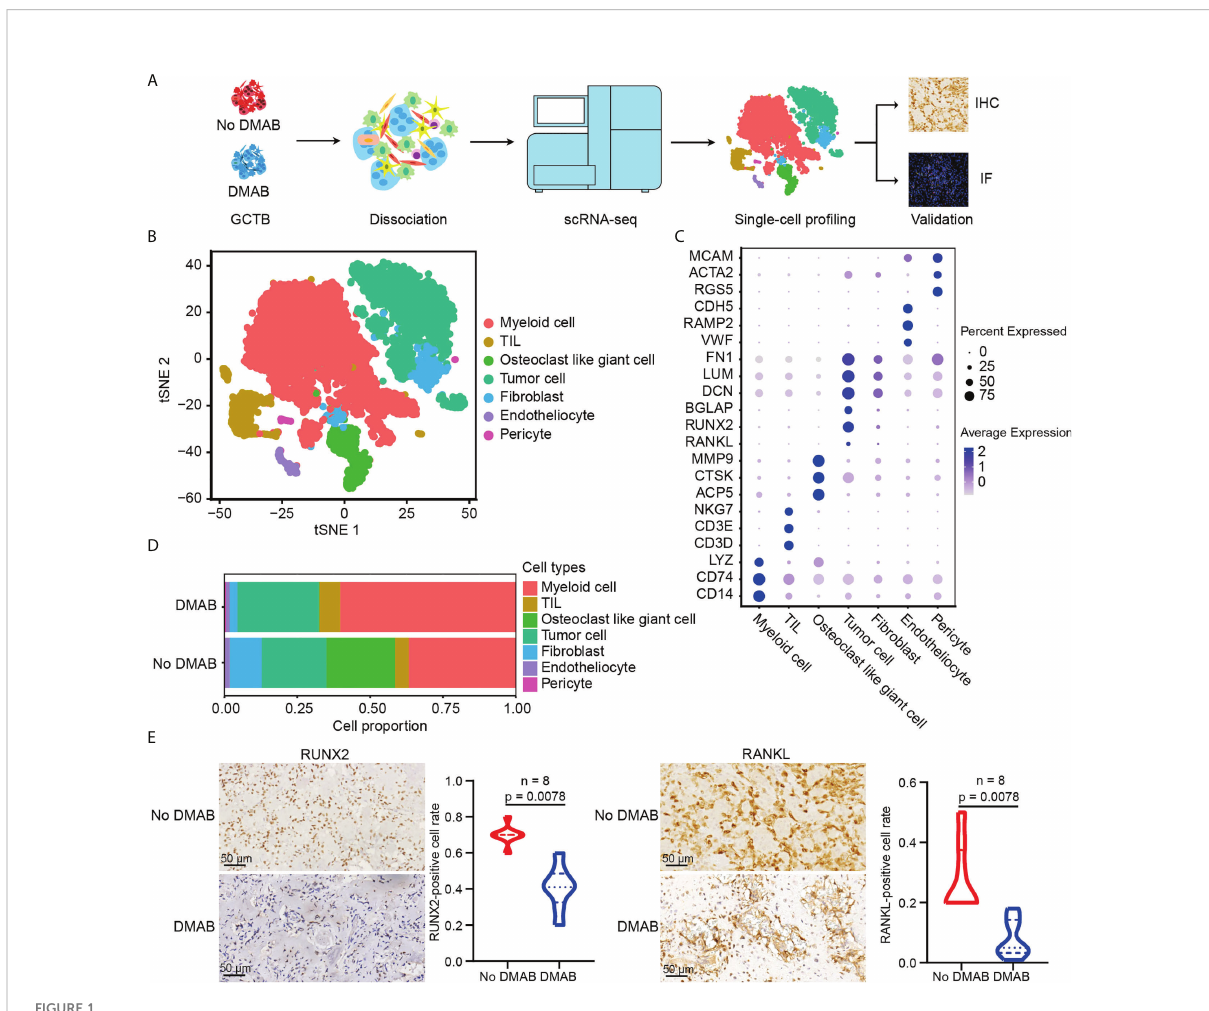
FIGURE 1 Single-cell RNA sequencing (scRNA-seq) pro fi ling of the untreated and DMAB-treated giant cell tumor of bone (GCTB) tumor microenvironments (TMEs). (A) Schematic representation of the experimental design. Single-cell suspensions were collected from GCTB tumors of two patients followed by scRNA-seq on 10× Genomics platform. A total of 13,857 quali fi ed single cells were recovered. (B) T-distributed stochastic neighbor embedding (t-SNE) plot showing the annotation and color codes for cell types in the GCTB ecosystem. (C) Dot plot showing the expression levels of marker genes in the indicated cell types. The size of the dot represents the proportion of cells expressing the particular marker within the group and the spectrum of color indicates the mean expression levels of the markers. Blue color dots indicate the highly expressed genes, while gray color dots indicate the low expressed genes. (D) Histogram showing the proportion of all cell types in untreated and denosumab (DMAB)-treated samples. (E) Representative images of immunohistochemistry (IHC) staining in formalin- fi xed paraf fi n-embedded (FFPE) tissues, indicating RUNX family transcription factor 2 (RUNX2) + cells and RANKL + cells in paired No DMAB and DMAB samples (n = 8). Scale bar, 50 m m. Violin plot presenting the fractions of RUNX2 + cells and RANKL + cells in paired No DMAB and DMAB samples based on IHC staining results. Statistical analyses are paired Wilcoxon